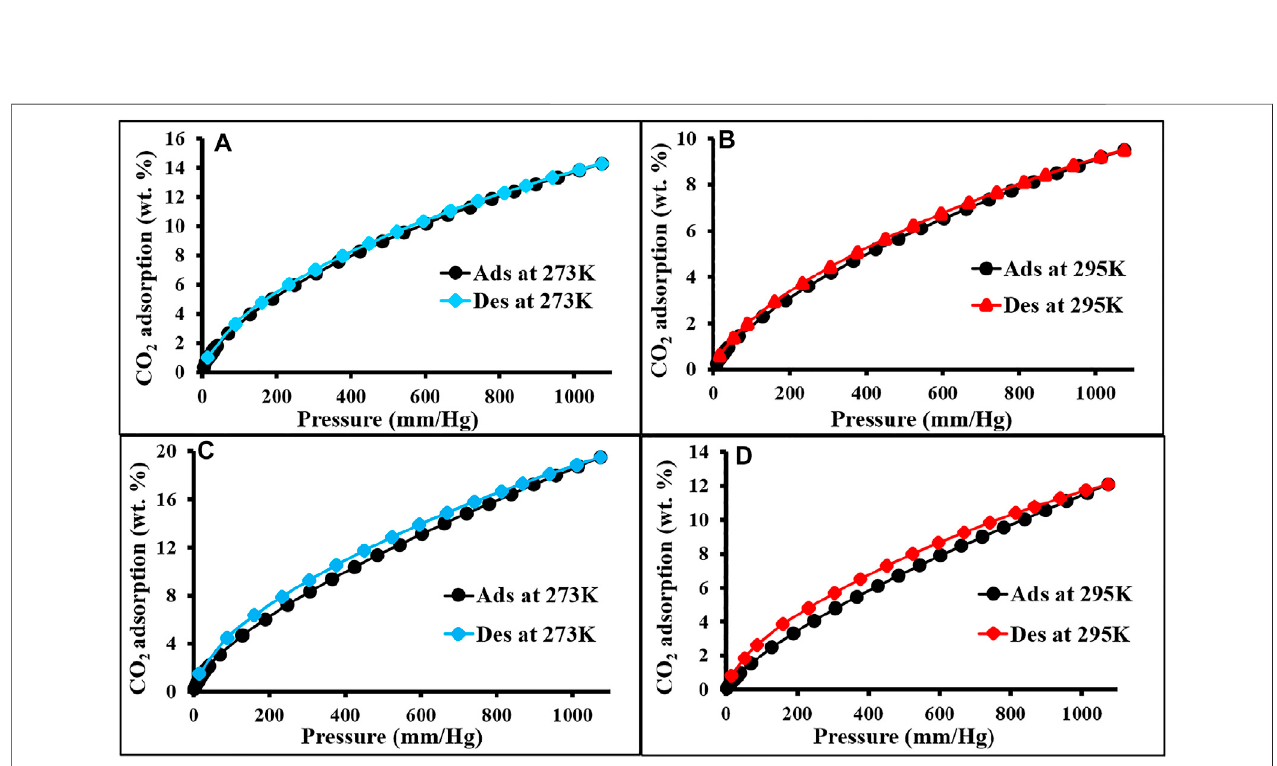
FIGURE 5 | CO 2 adsorption and desorption isotherm of c-2CzPN – KOH (A,B) and c-4CzPN – KOH (C,D) at 273 and 295 K, respectively.